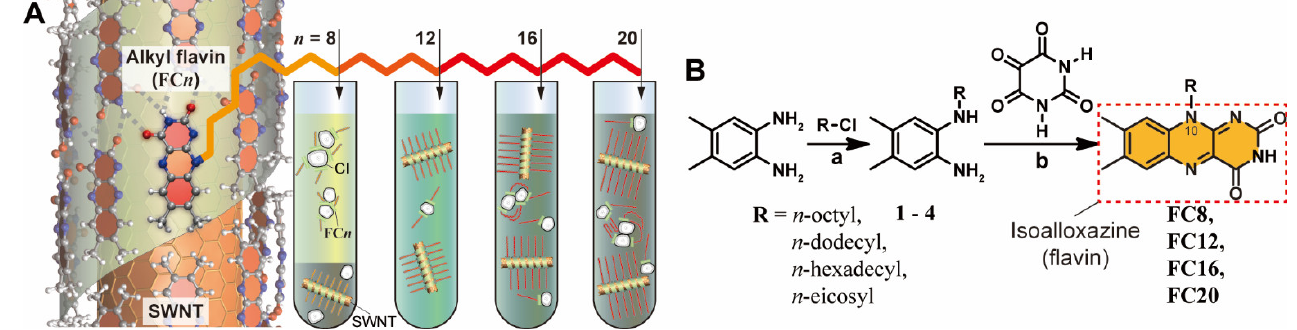
Figure 1. ( A ) Schematic showing the effect of flavin l S on the SWNT dispersions. (Left) SWNT wrapped by helical isoalloxazine wrapping with n -alkyl side chains. (Right) l S -induced SWNT dispersion containing flavin-wrapped SWNTs and CIs with different degree. ( B ) Synthetic routes to prepare FC8 , FC12 , FC16 , and FC20 . Note that N10 site for different l S is indicated. Conditions: (a) TEA, 130 °C, 12 h; yield: 1 : 32%, 2 : 60%, 3 : 46%, 4 : 25%; (b) glacial acetic acid, B 2 O 3 , 60 °C, 6 h; yield; FC8 : 56%, FC12 : 58%, FC16 : 53%, FC20 : 50%.